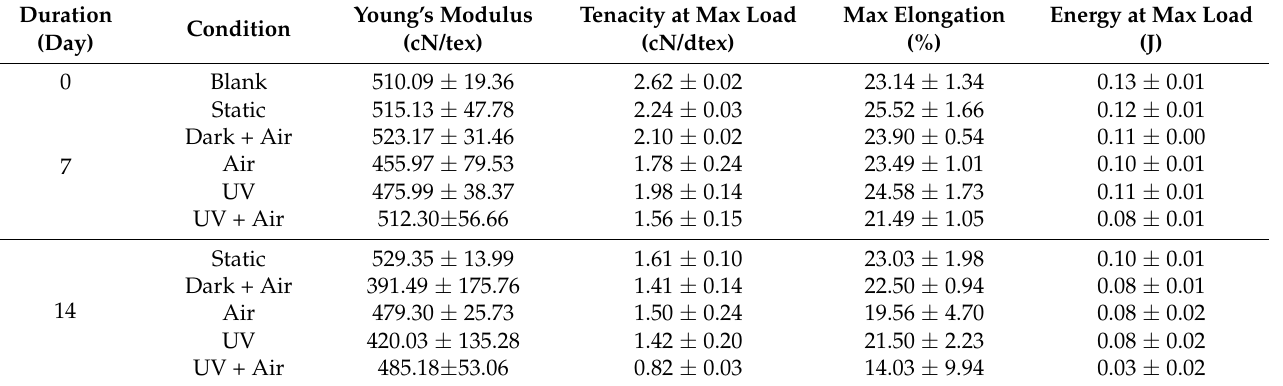
Figure 5. Evolution of tensile behavior of multi-filament PLA/PHB yarns ( A ) before (blank) and after 7 days immersed in natural seawater under different conditions; ( B ) after 14 days immersed in natural seawater under various conditions. Table 2. Tensile properties of multi-filament PLA/PHB yarns after immersion in seawater under different conditions.